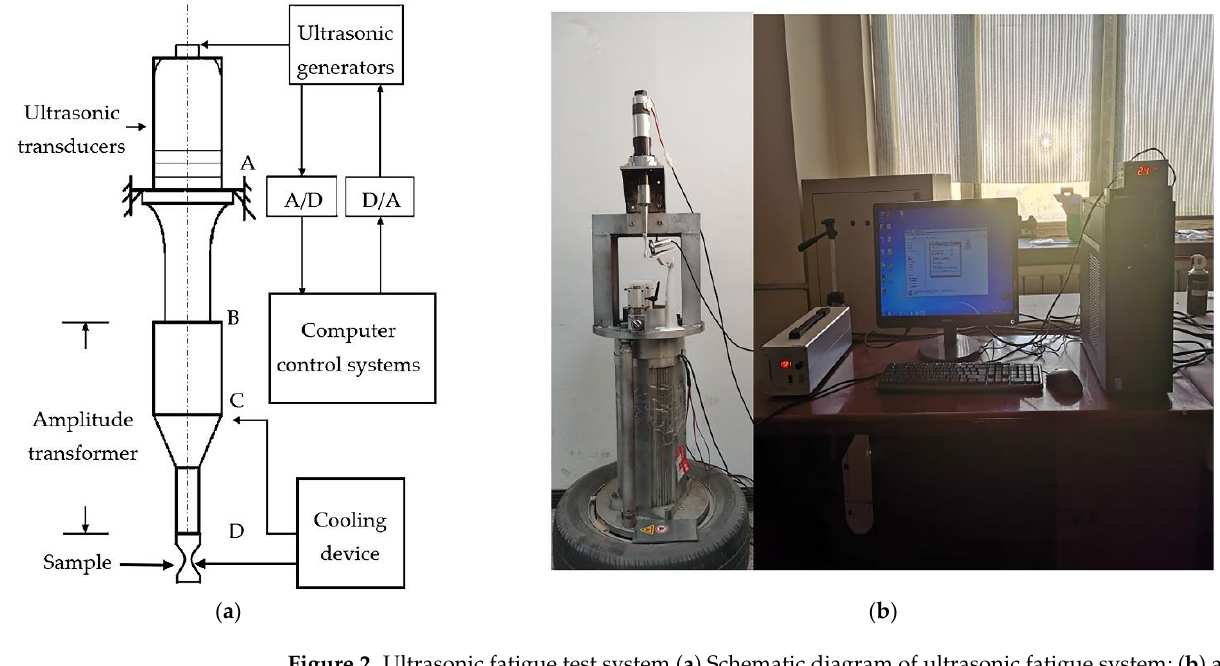
Figure 2. Ultrasonic fatigue test system ( a ) Schematic diagram of ultrasonic fatigue system; ( b ) actual test machine.